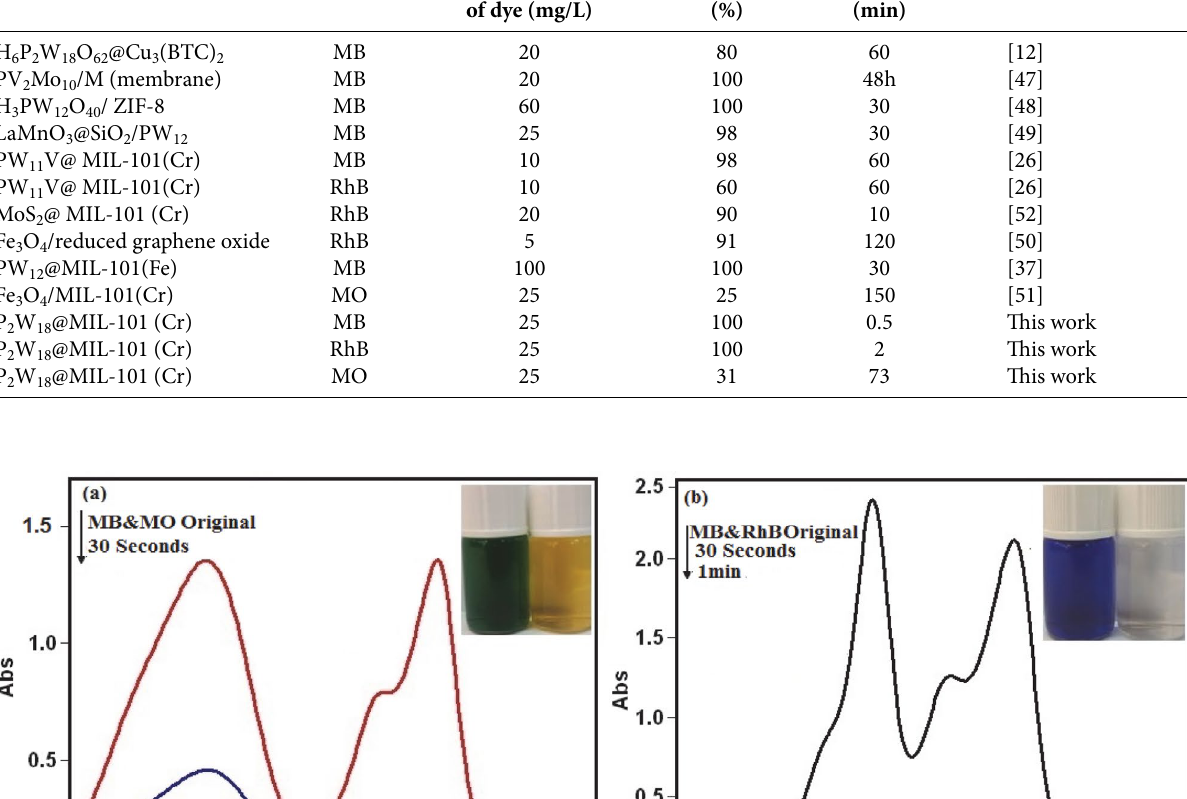
Table 2. Comparison of the results of the newly synthesized nanohybrid with some reported adsorbents for the removal of dye pollutants. Adsorbent Dye pollutant